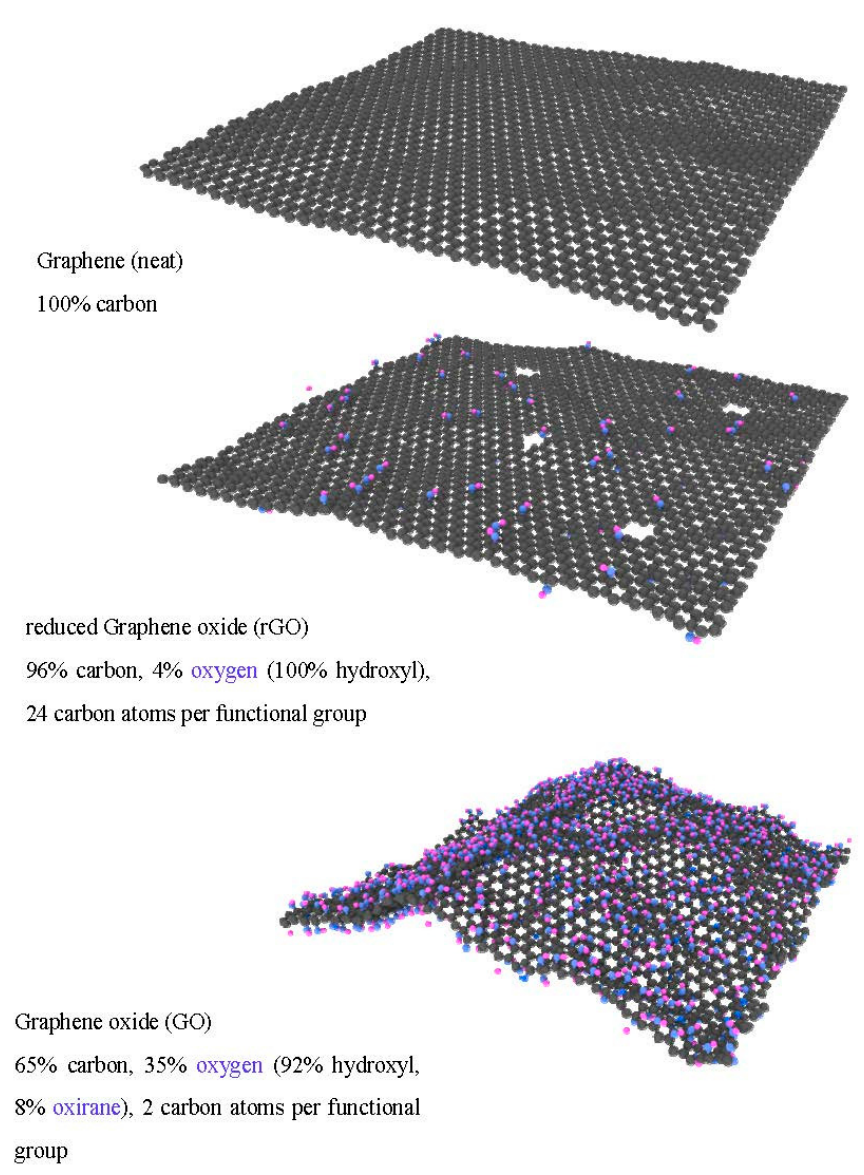
Figure 2. Type of graphene models with details of surface functionalization (percentages are atomic).